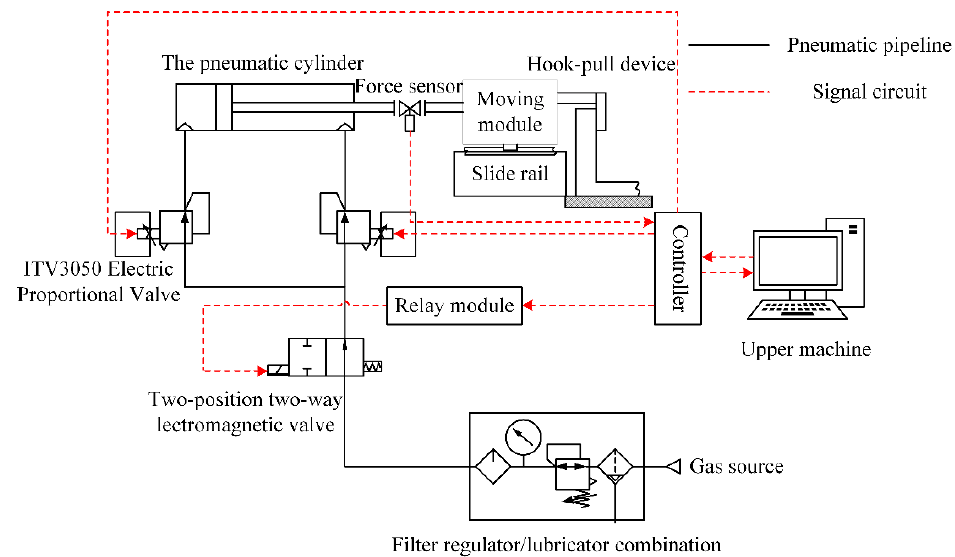
Figure 8. Schematic diagram of clamp’s pneumatic servo control